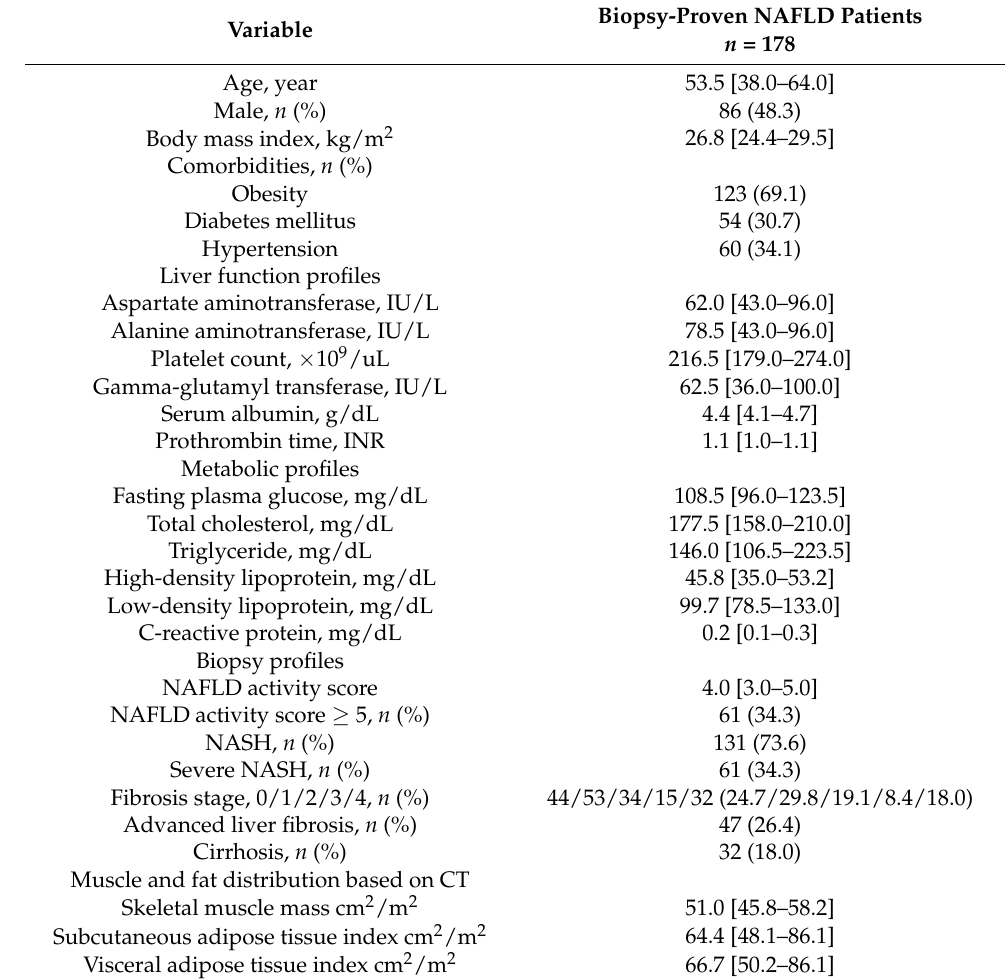
Table 1. Baseline